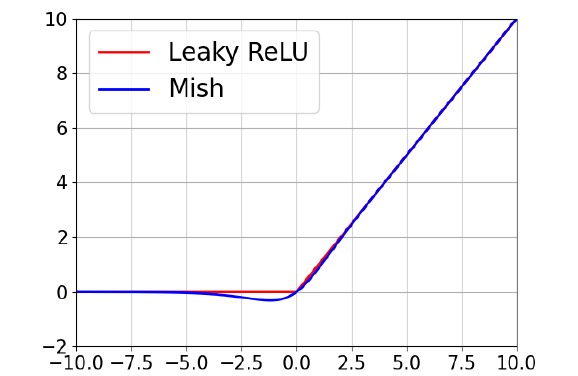
Figure 5. Comparison of the activation function curves between Leaky ReLU and